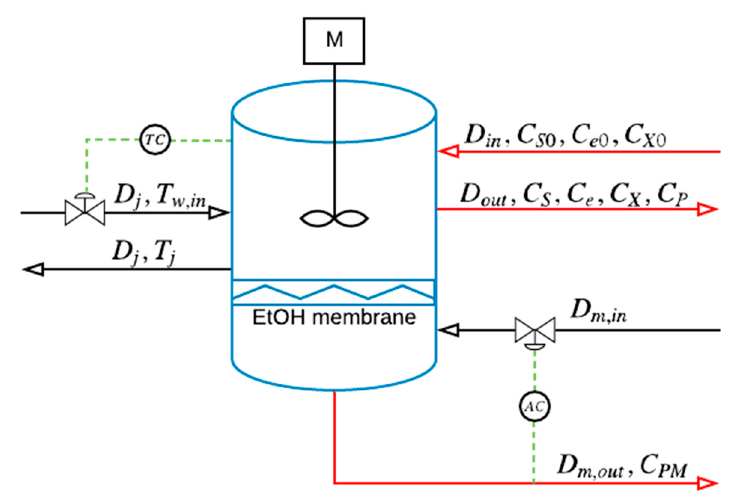
Figure 1. Schematic diagram of the fermentation reactor.